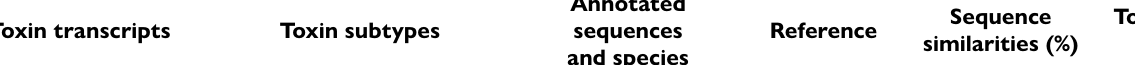
Table 4. Other putative neurotoxins in C. bivirgata flaviceps venom gland transcriptome.